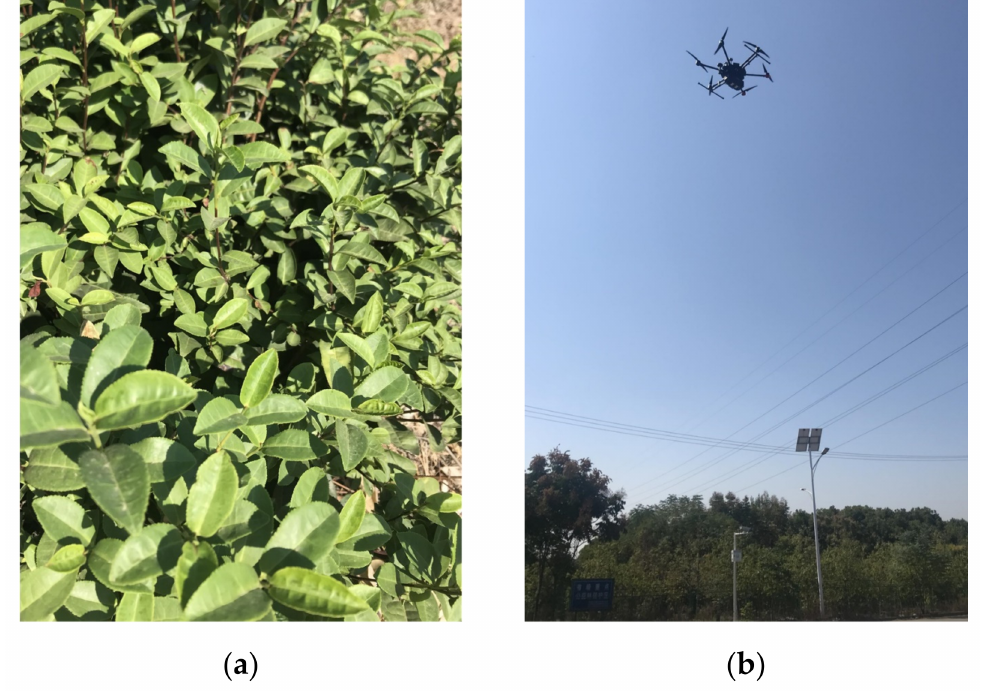
Figure 3. ( a ) Field survey; ( b ) UAV data acquisition in the